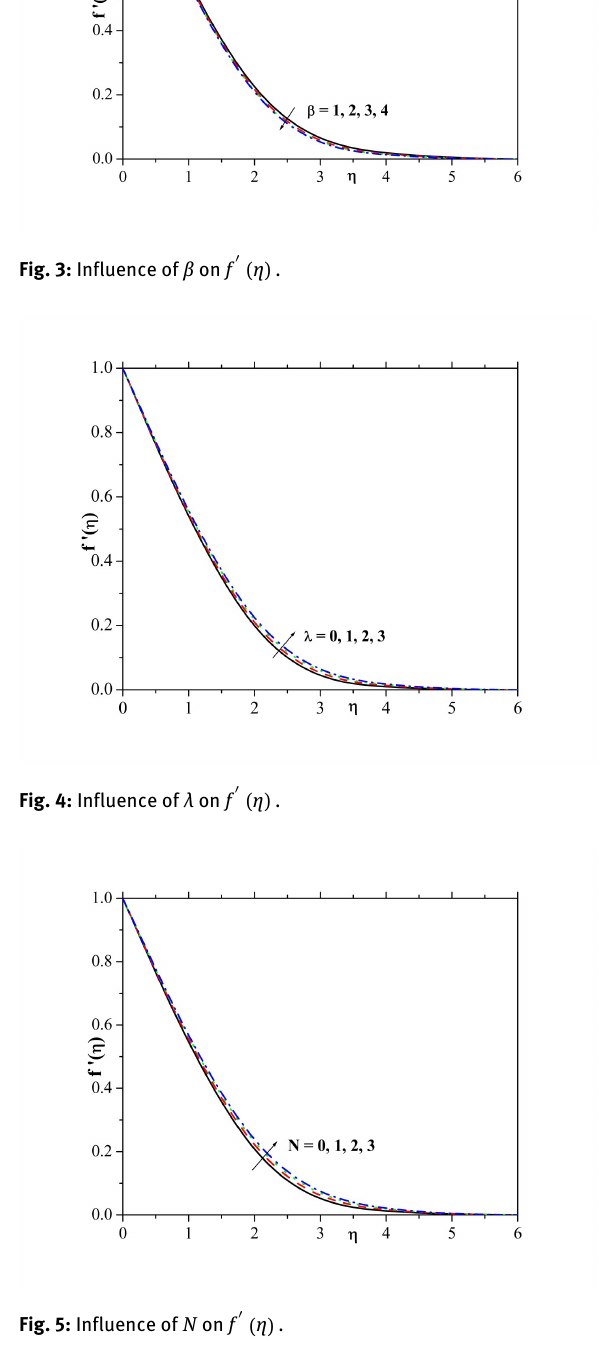
Fig. 5: Influence of N on f ′ ( η )